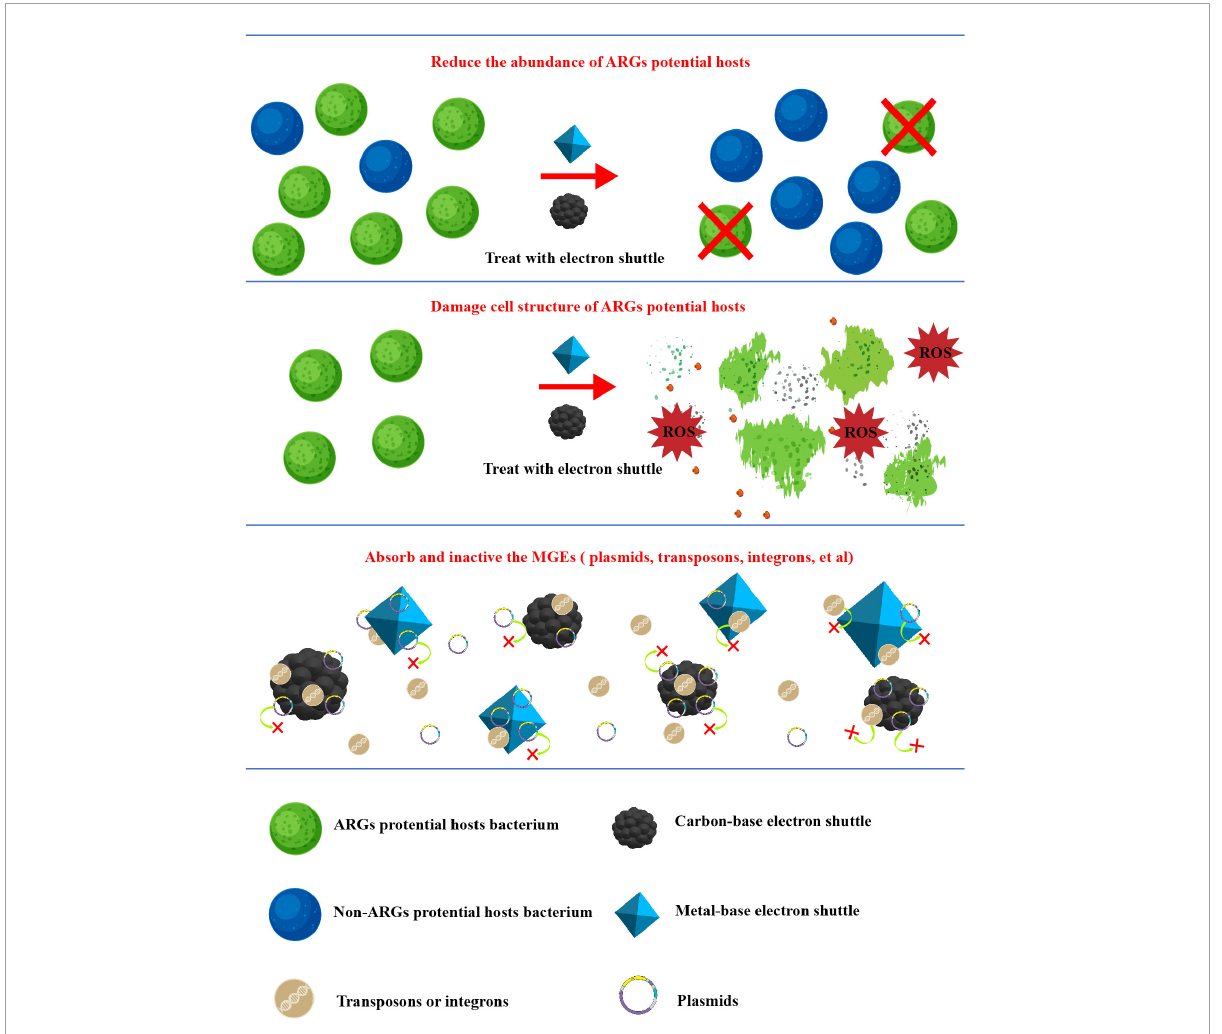
FIGURE3 Possible mechanisms of electron shuttle enhanced anaerobic treatment of ARGs.